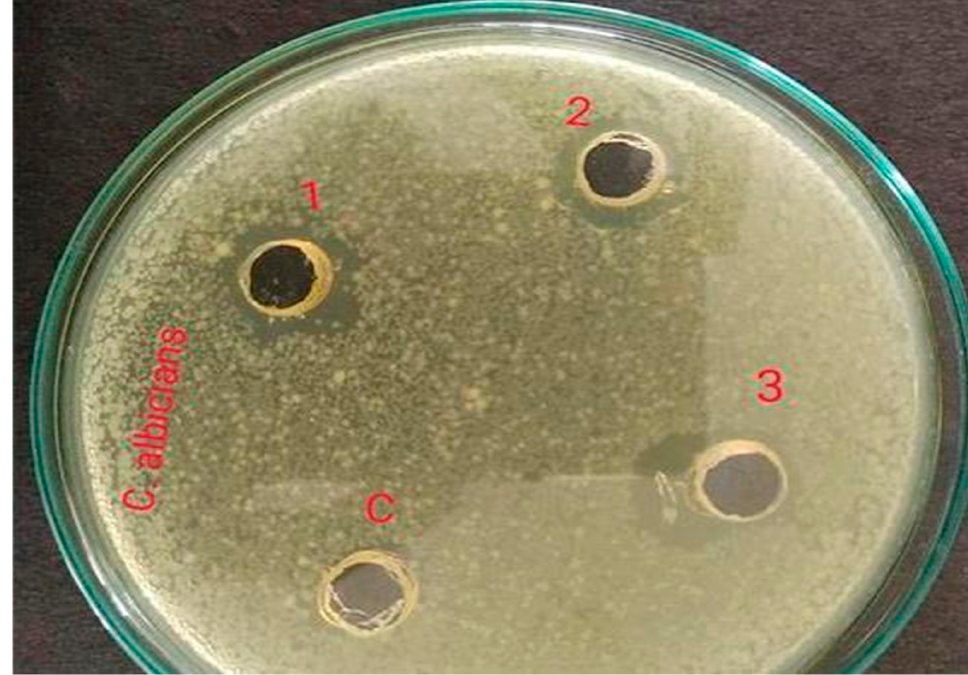
Figure 3. Zone of inhibition of Vigna radiata extract toward Candida albicans ( 1 ) 12.4 mm, ( 2 ) 12.3 mm, ( 3 ) 12.5 mm and ( c ) control.